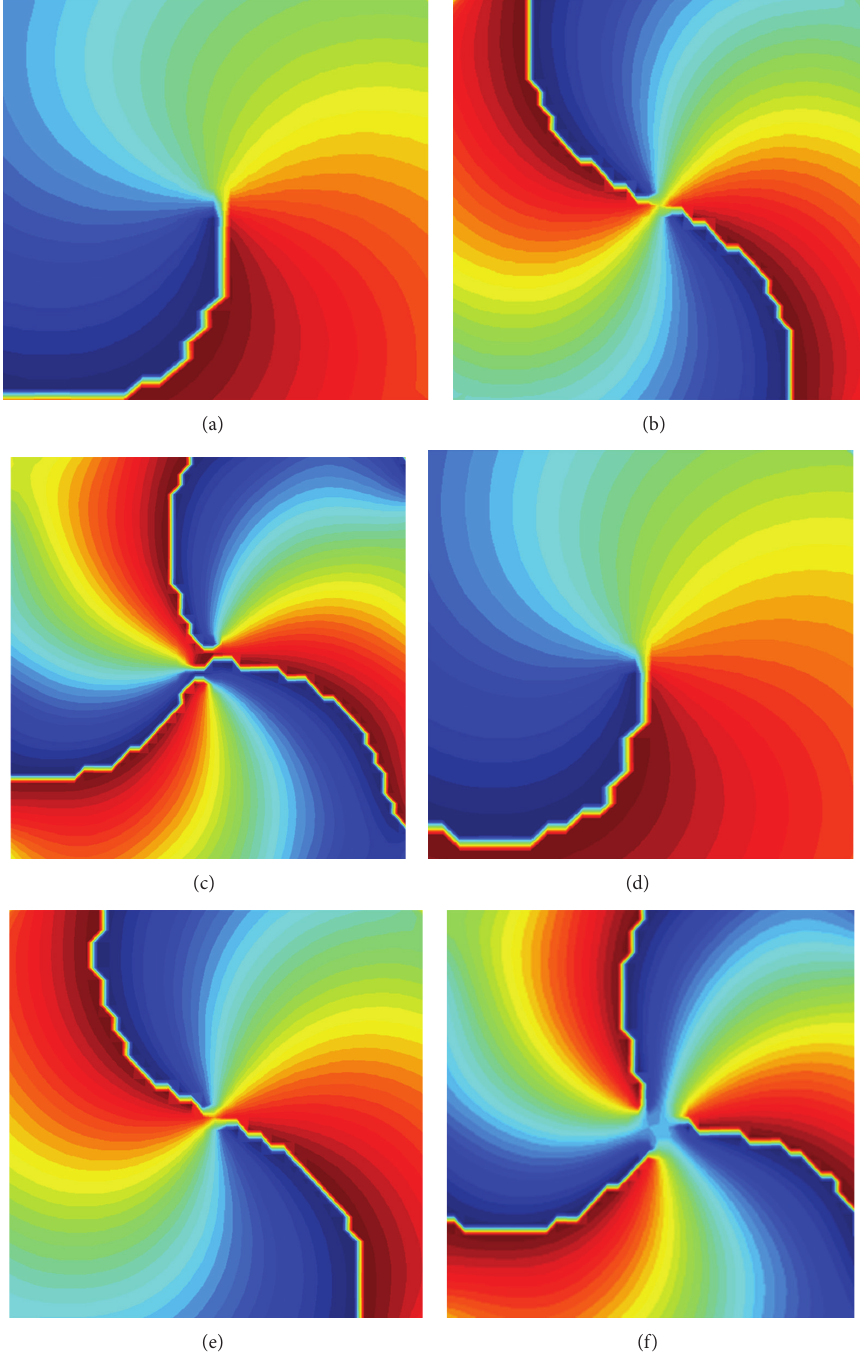
Figure12:ThehelicalphasefrontofOAMradiobeams.Linearpolarization:(a) ℓ = +1 ,(b) ℓ = +2 ,and(c) ℓ = +3